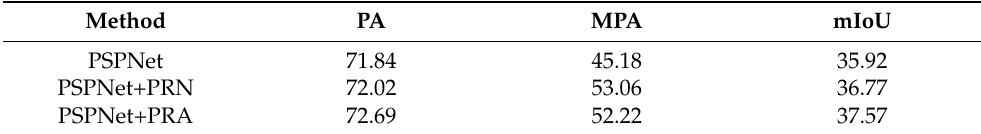
Table 1. Comparison of pixel sampling method based on different data